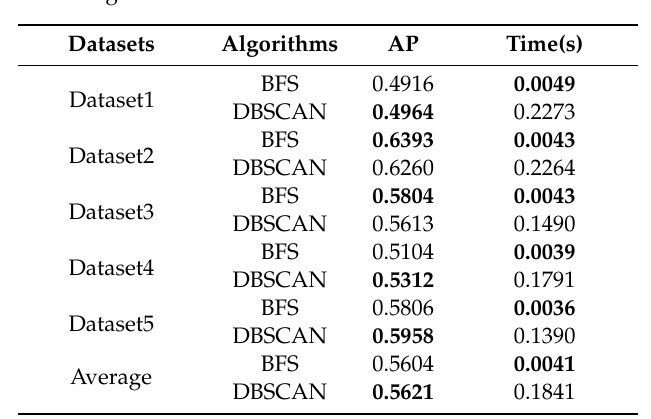
Table 2. Breadth first search (BFS)-based and density-based spatial clustering of application with noise (DBSCAN)-based candidate selecting algorithms’ AP (average precision) and the time they take to select candidates in one